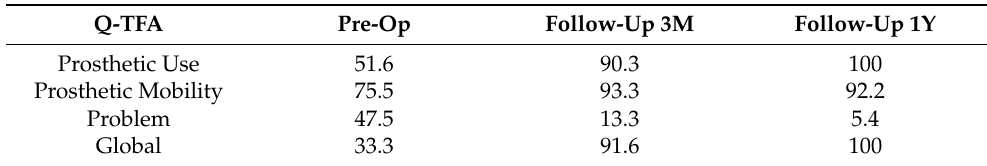
Table 6. Q-TFA values for the pre-operative and follow-up related quality of life evaluation for a person with transfemoral amputation. The data range is from 0 to 100. Q-TFA Pre-Op